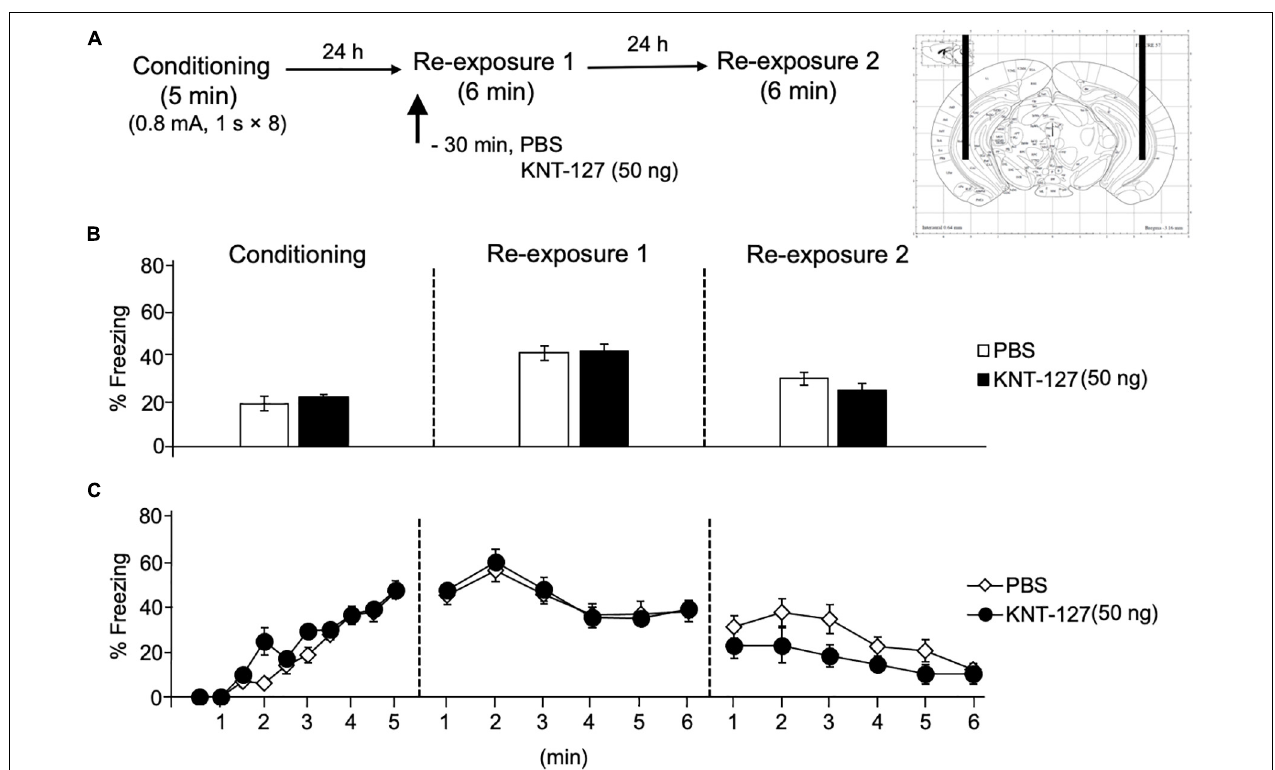
FIGURE 8 | Intra-HPC administration of KNT-127 produced no significant effects on contextual fear memory. Intra-HPC administration of KNT-127 does not affect the extinction of contextual fear. (A) Experimental design. Mice were bilaterally administered with PBS ( n = 14) or KNT-127 ( n = 8 for 50 ng) into the HPC 30